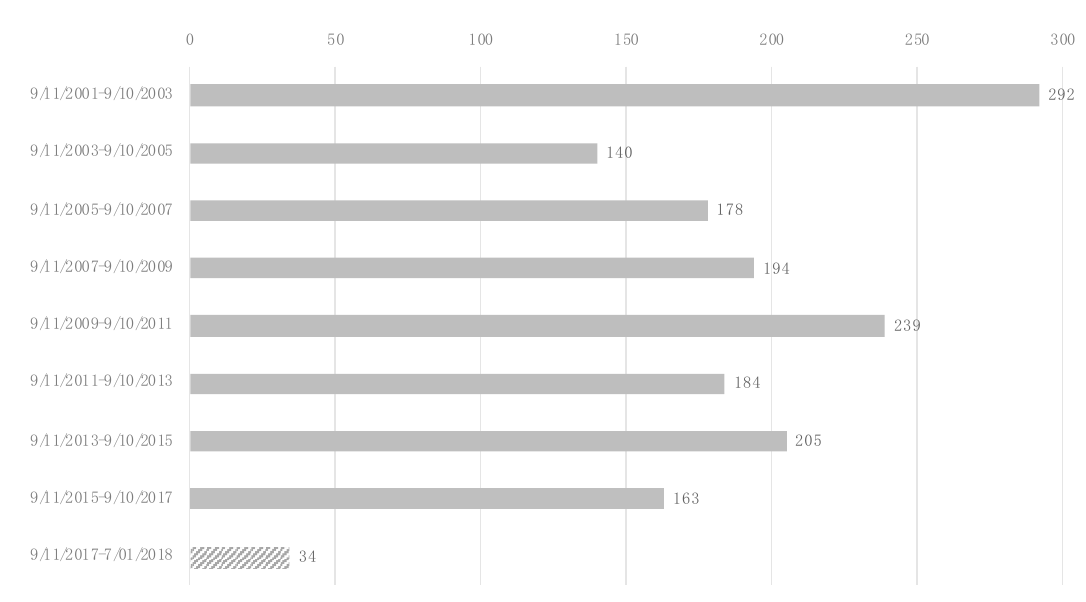
Figure 2. Distribution of individuals initiating ICS/LABA for more than 2 years ( n = 1629) per time interval. The first interval, 11 September 2001–10 September 2003, with 292 individuals starting ICS/LABA treatment, had the highest number. In the other, full 2-year intervals the numbers of individuals initiating ranged from 139 to 239 per 2-year time interval. The last interval 11 September 2017–1 July 2018, which was not a full 2-year interval (striped filling pattern), contained 34 individuals with ICS/LABA initiation. Table 1. Demographics comparing the full study population with the ICS / LABA-treated population. Variable